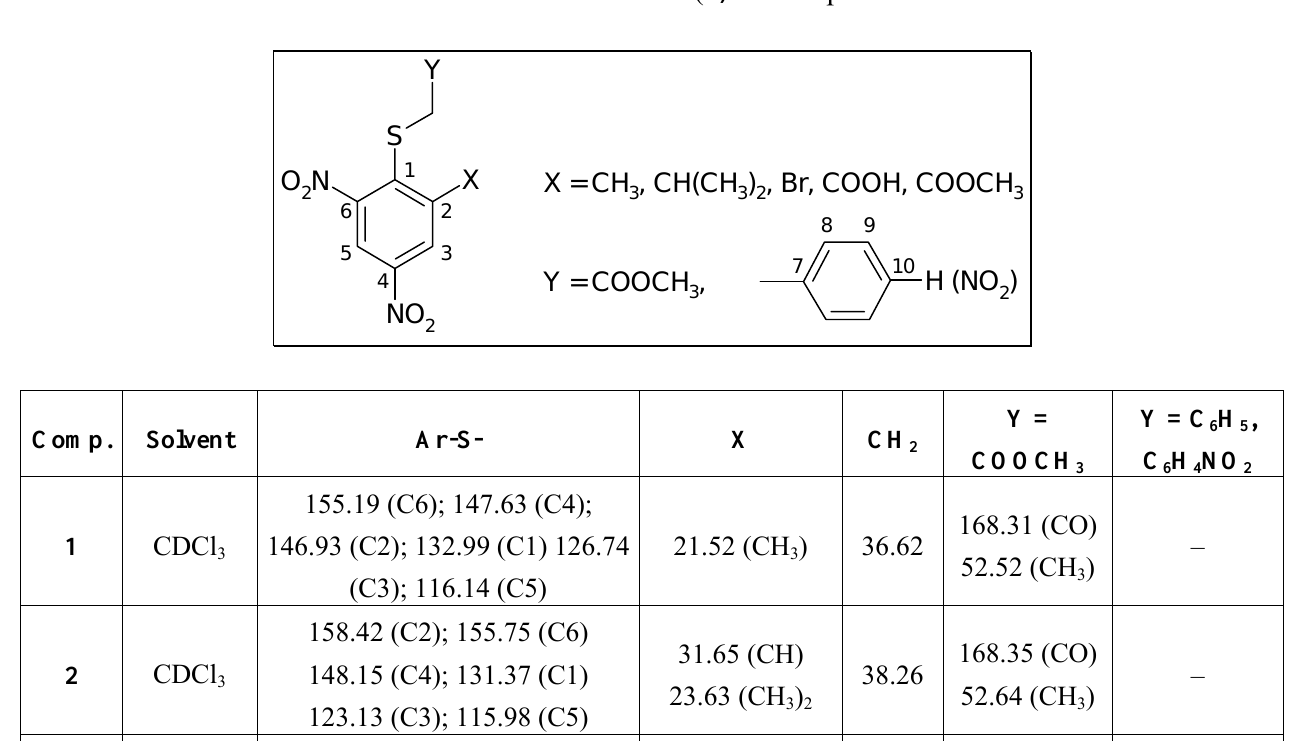
Table IIb. 13 C-Chemical Shifts ( δ) of Compounds 1 (cid:150)